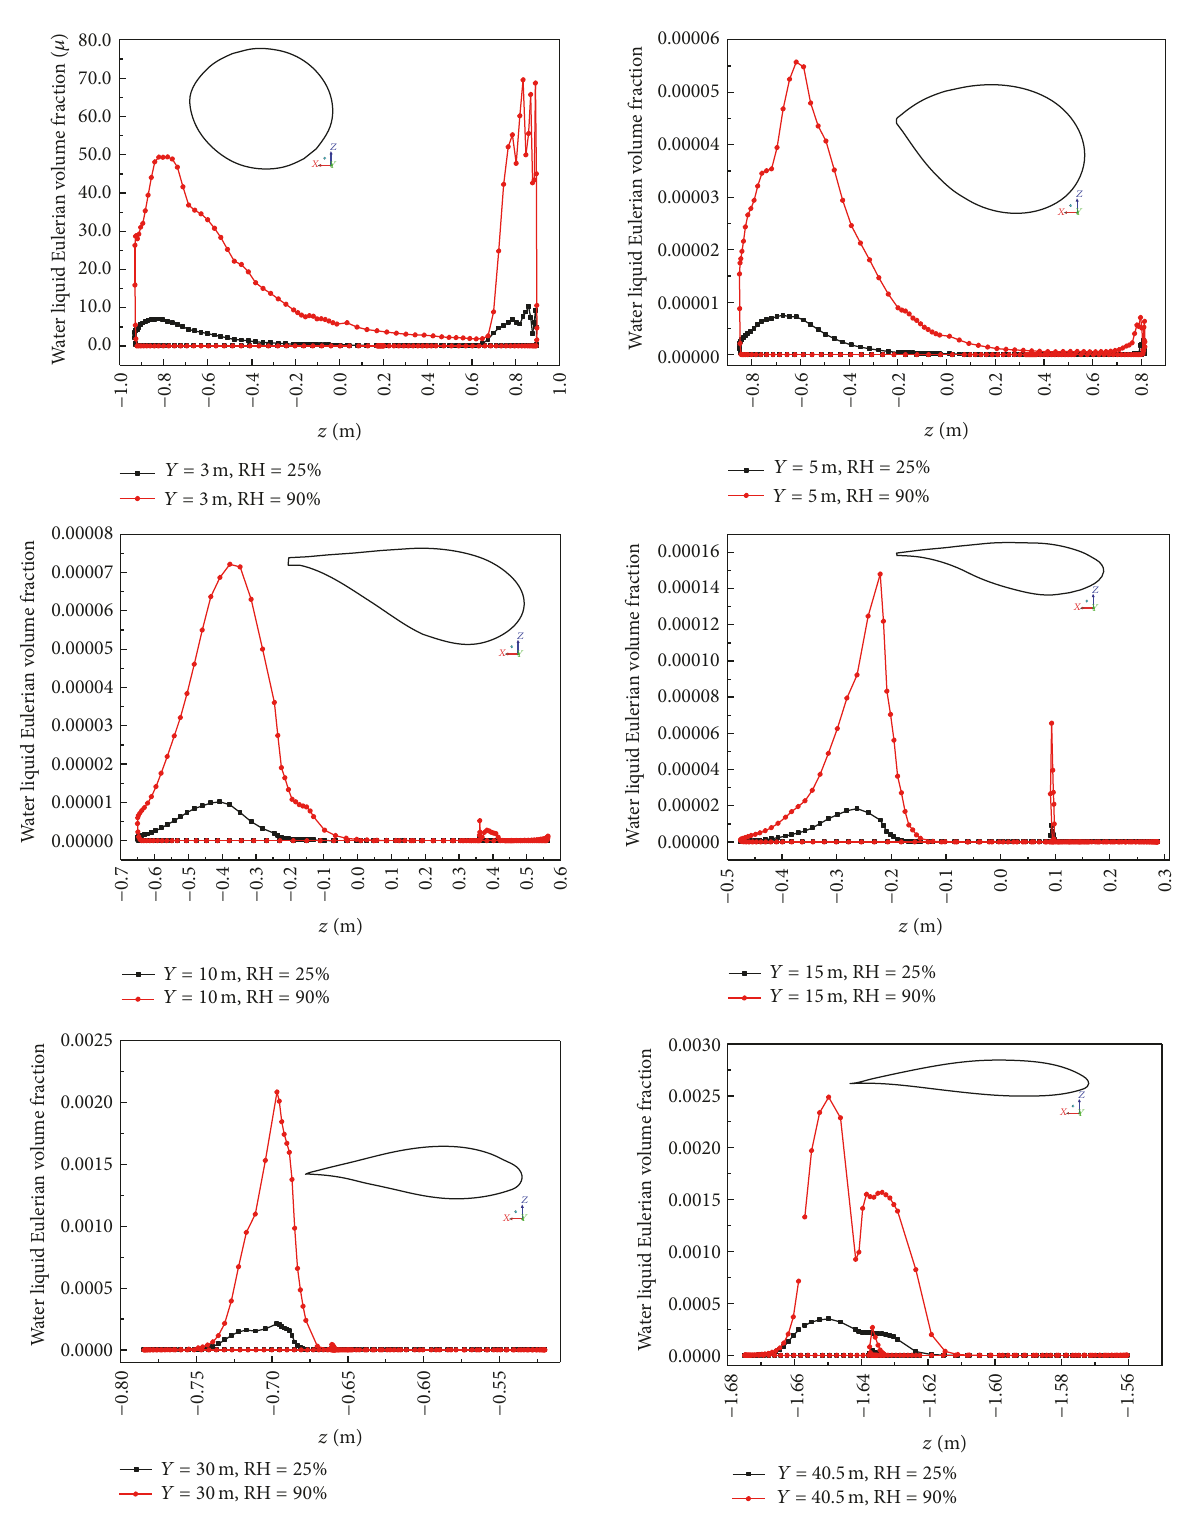
Figure 17: Water volume fraction at various spanwise location for RH = 25% and 90% (EWF